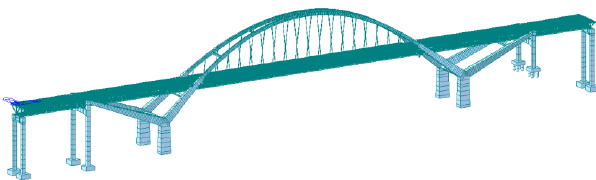
Figure 2. The finite element model of the bridge. Table 1. The material properties.